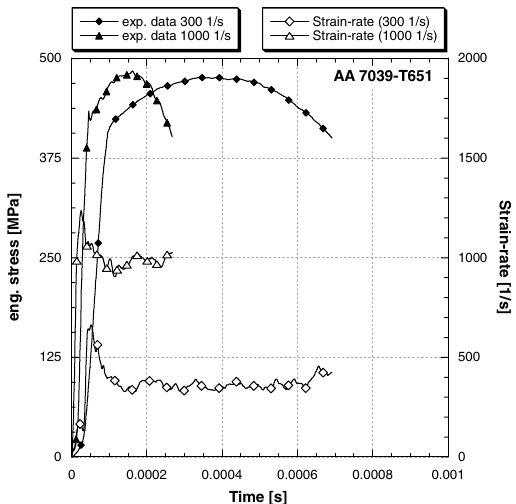
Fig. 5. Engineering stress and strain-rate versus time @ 300s − 1 and 1000s − 1 for AA 7039-T651.